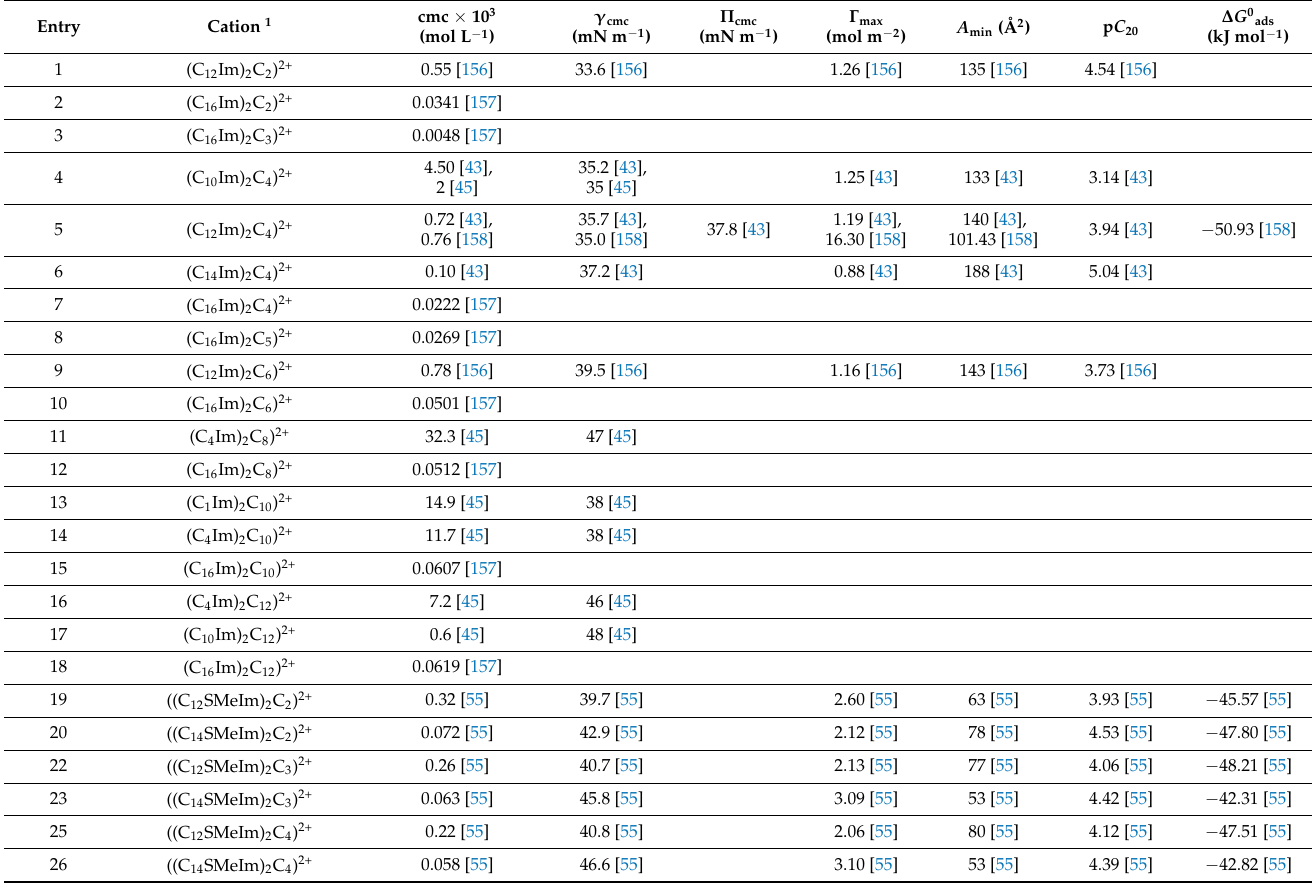
Table 2. Literature data on aqueous solutions of gemini ionic liquid-based surfactants at 25 ◦ C. Adsorption and micellar parameters calculated from surface tension data. All surfactants have two bromides as counterions, except for entries 54 and 55, which have three bromides as